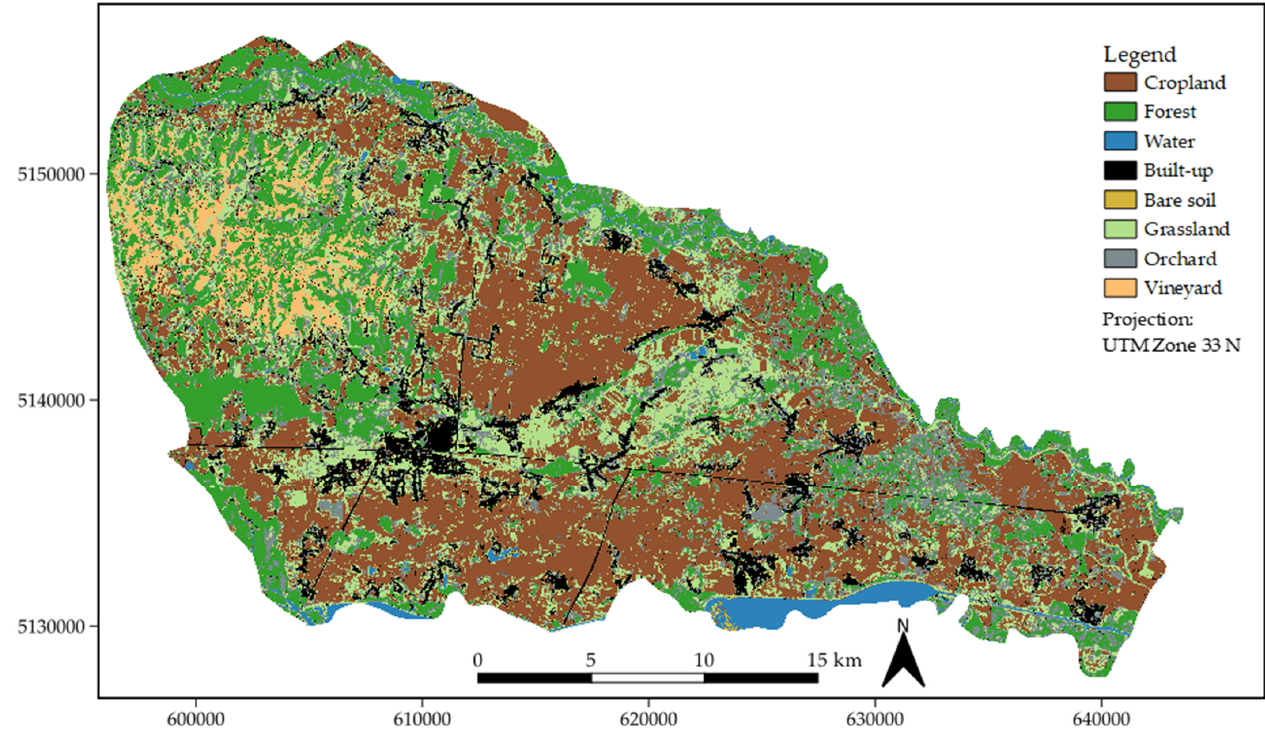
Figure 6. Spider chart representing the User’s (UA) and Producer’s accuracy (PA) for each LC class in the: ( a ) S1; ( b ) S1 with GLCM; ( c ) S2; ( d ) S2 with Indices; ( e ) All; ( f ) S1 with S2 classification scenario. Figure 7 represents the best supervised pixel-based classification scenario (i.e., S1